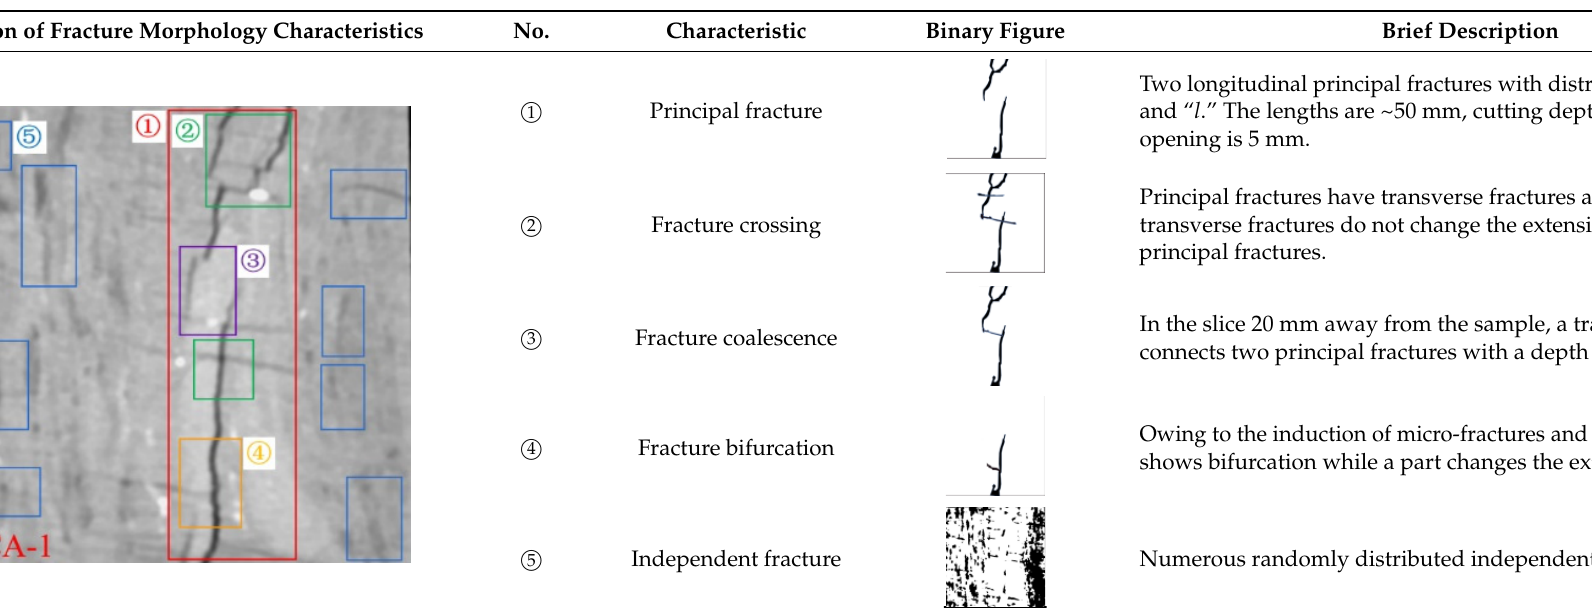
Table 1. Fracture characteristics in coal mass.